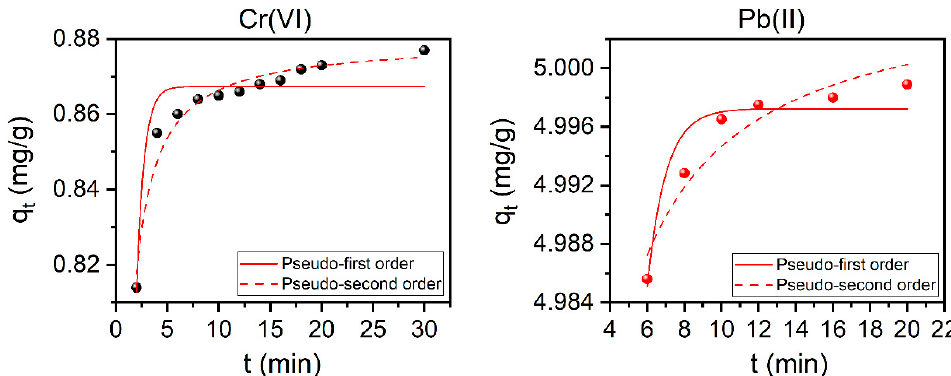
Figure 8. Pseudo-second-order kinetic models for the adsorption of both Cr(VI) ( left ) and Pb(II) ( right ) ions using the modified Ch-based AC (10Ch600.60K 2 CO 3 .U). Conditions: Cr(VI) and Pb(II) C i: 10 mg/L; AC dose: 10 g/L; Cr(VI) pH: 2, Pb(II) pH: 6; and T: 25 °C.